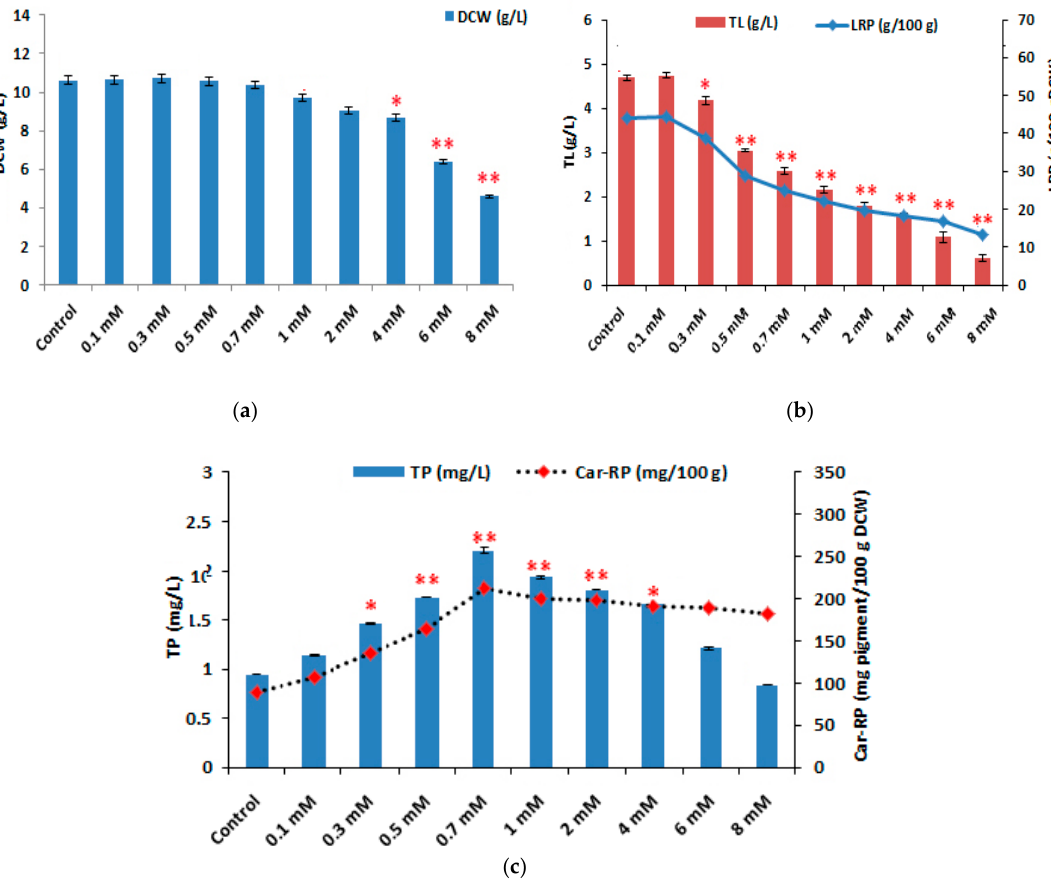
Figure 4. Influence of different Al 2 (SO 4 ) 3 concentrations on growth, and lipid and carotenoid production by Rhodotorula glutinis . Yeast cells were grown in the shaken flask using the optimised medium as a control with C/N equal to 146 (using ammonium sulfate as a sole nitrogen source) and C/S equal to 120, and incubated at180 rpm and 28 °C for six days: ( a ) dry cell weight (DCW) (g/L), ( b ) total lipid (TL (g/L)) and lipid relative productivity (LRP = (g lipid /g DCW ) × 100), and ( c ) total pigment (TP mg/L) and carotenoid relative productivity (Car-RP mg pigment /100 g DCW ). The data are the mean of three repeated tests, and the standard deviation was calculated and represented as an error bar. Asterisks ** represent a statistically significant difference between the single-Al-treated group and the control at p ≤ 0.01, and asterisk * represents a statistically significant difference between single-Al-treated group and control at 0.01 < p ≤ 0.05.